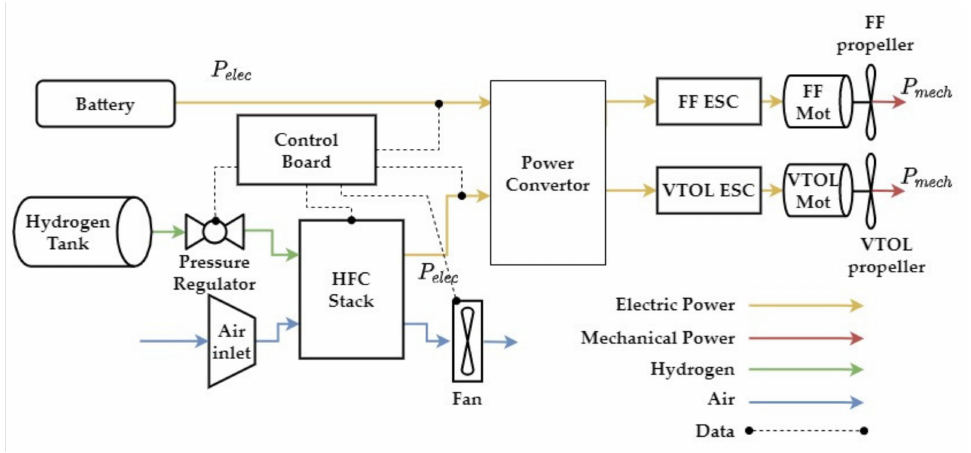
Figure 2. Multi-mode HFC eVTOL UAV propulsion system concept.